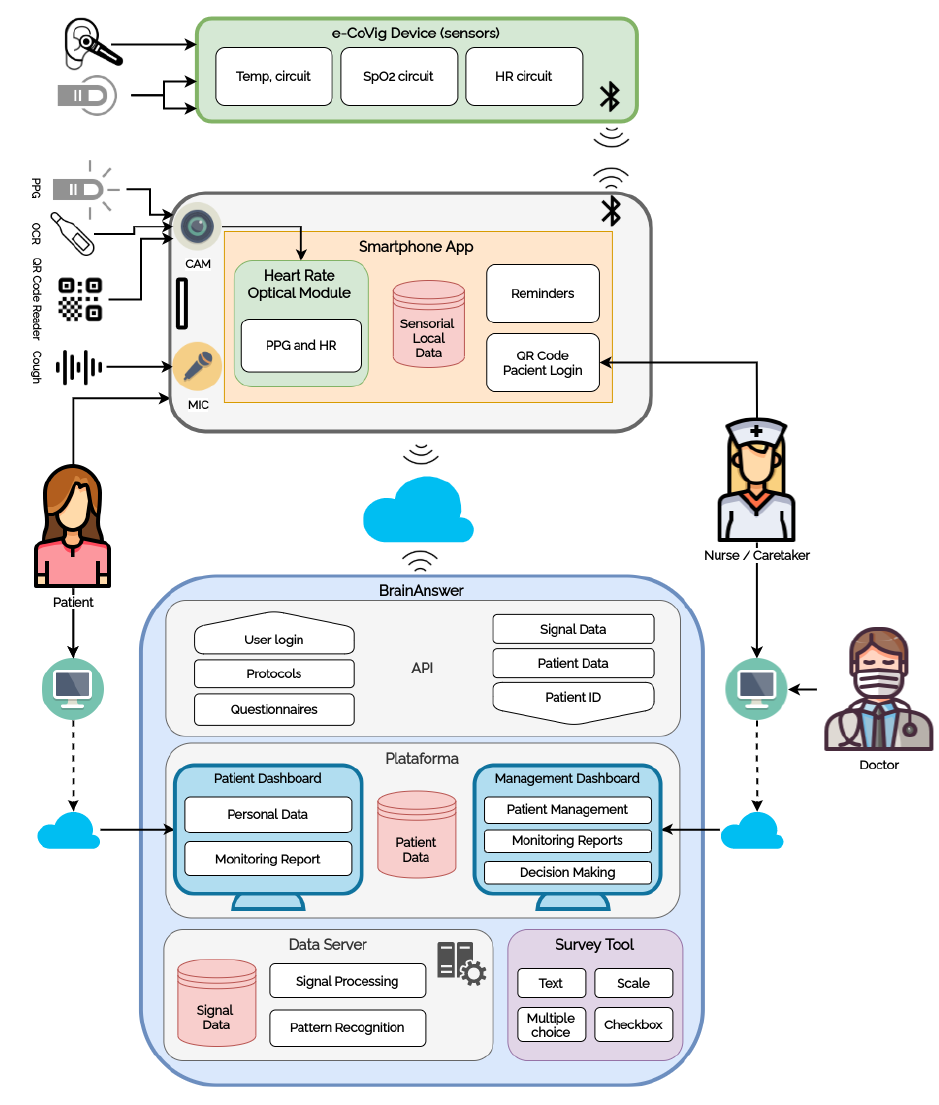
Figure 2. Detailed e-CoVig mHealth system